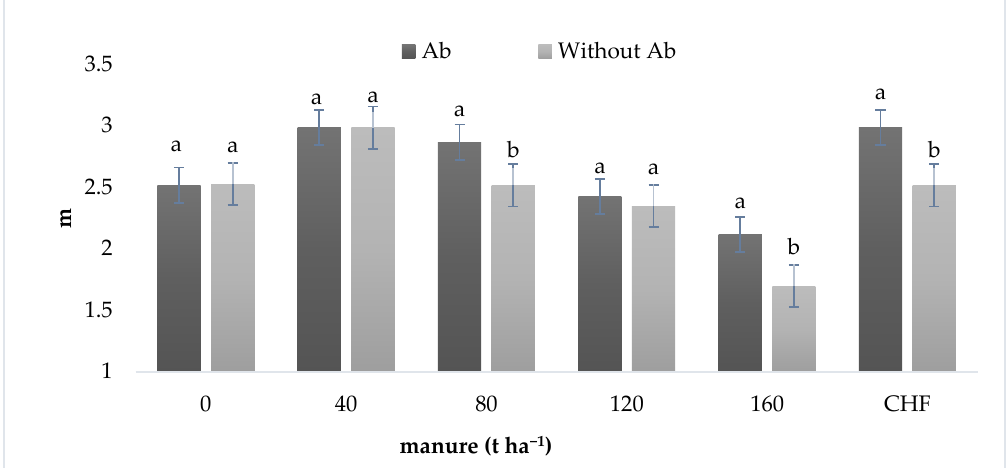
Figure 1. Interaction of Ab–fertilization in plant height at 5 months; Ab: Azospirillum brasilense ; 0, 40, 80, 120, 160 = manure t . ha −1 ; CHF: chemical fertilization. Different literals in the bars indicate significant difference with p < 0.05.